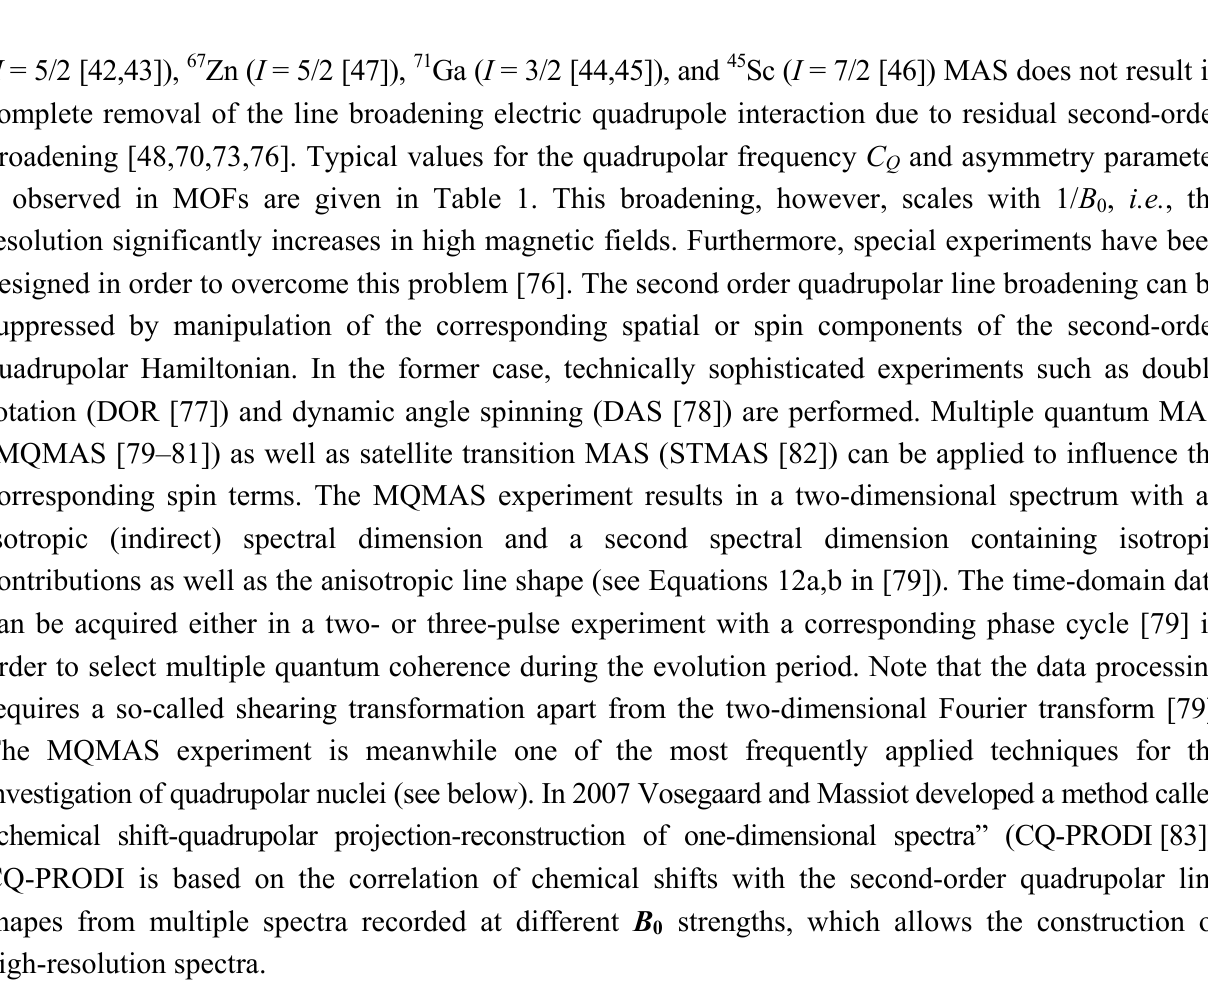
and η as observed for several MOFs.